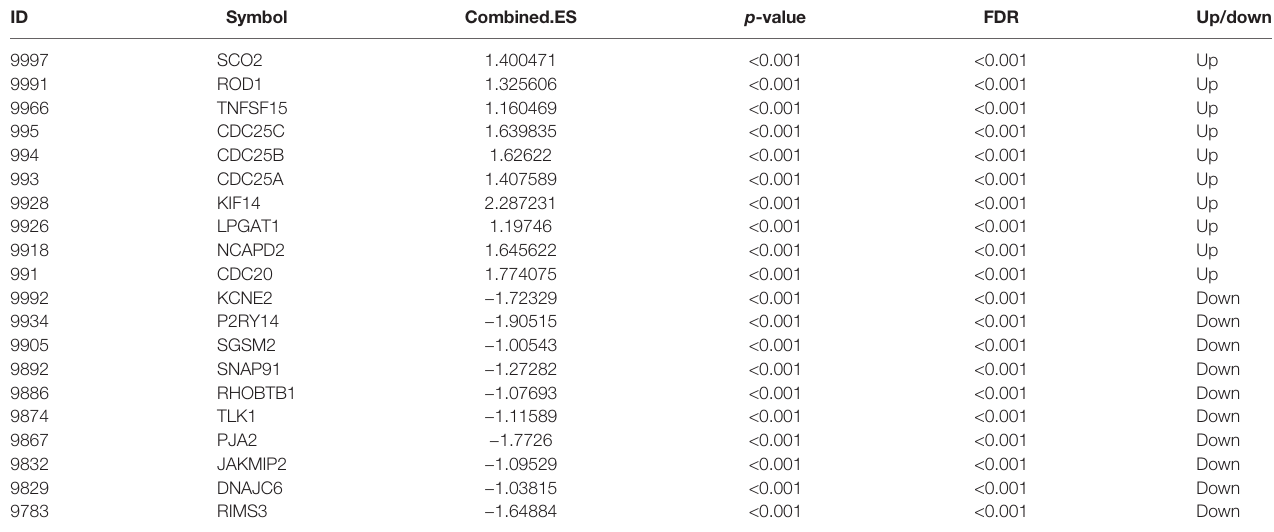
TABLE 4 | The top 10 upregulated and downregulated mRNAs in